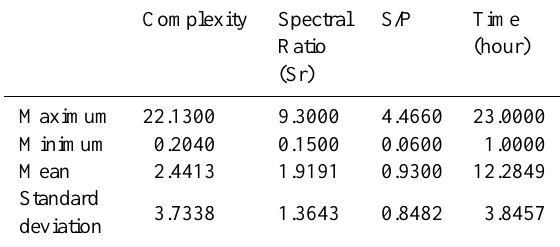
Table 1. Fundamental descriptive statistical information about the data and their